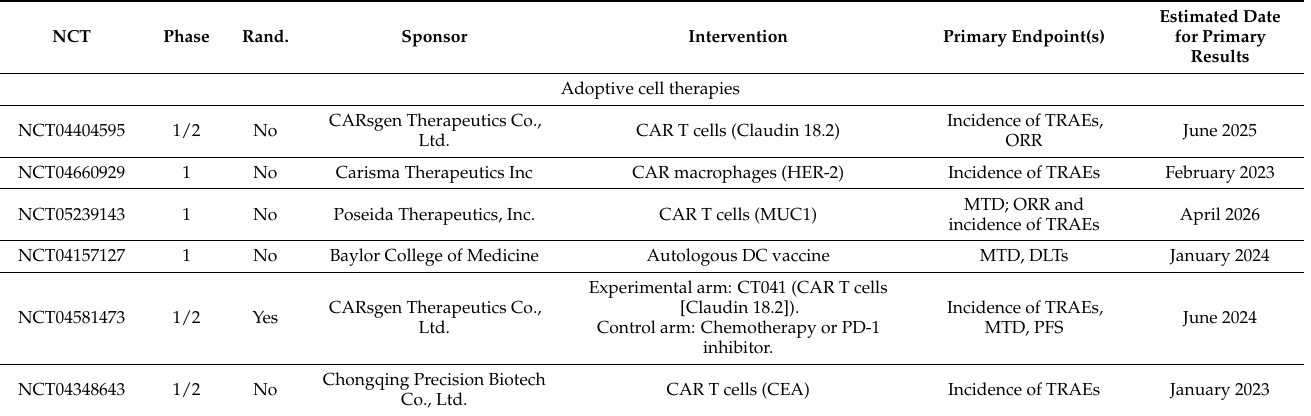
List of currently recruiting multicenter clinical trials determining clinical out- comes of adoptive T-cell therapies and vaccines in patients with pancreatic